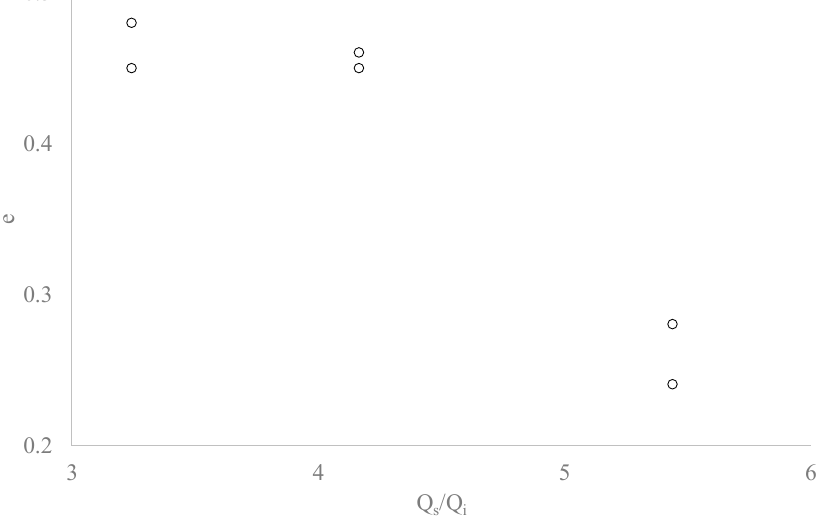
Q ) and sediment ( i